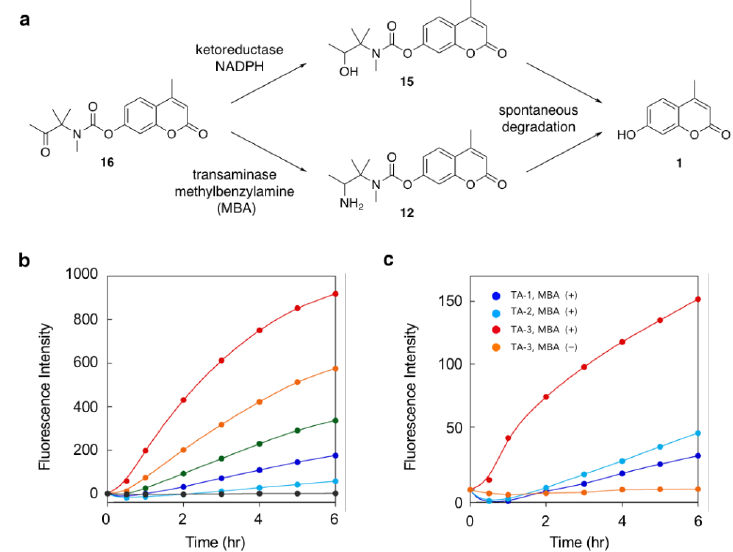
Figure 4. Fluorescence detection of enzyme-catalyzed conversion of keto probe 16 . ( a ) Sequential reactions of 16 to release 1 , induced by ketoreductase or transaminase. ( b ) Time-trace plot of fluorescence intensity change (λ em = 450 nm) upon incubation of 16 with 0.2, 0.5, 1, 2, and 5 mg/mL of ketoreductase K-6 (from lower to upper curve) in presence of NADPH. The lowest black line indicates the result with 5 mg/mL of K-6 in absence of NADPH. Measurement conditions: [ 16 ] = 10 µM, [NADPH] = 0.2 mg/mL, [glucose] = 10 mg/mL, [glucose dehydrogenase] = 0.2 mg/mL, λ ex = 320 nm, 50 mM phosphate buffer, pH 8.0, 30 °C. ( c ) Time-trace plot of fluorescence intensity change (λ em = 450 nm) upon incubation of 16 with transaminase TA-3 in the presence or absence of methylbenzylamine (MBA). Measurement conditions: [ 16 ] = 10 µM, (transaminase) = 5 mg/mL, (MBA) = 11.5 µM, (pyridoxal phosphate) = 0.1 µM, λ ex = 320 nm, 100 mM phosphate buffer, pH 7.0, 30 °C.